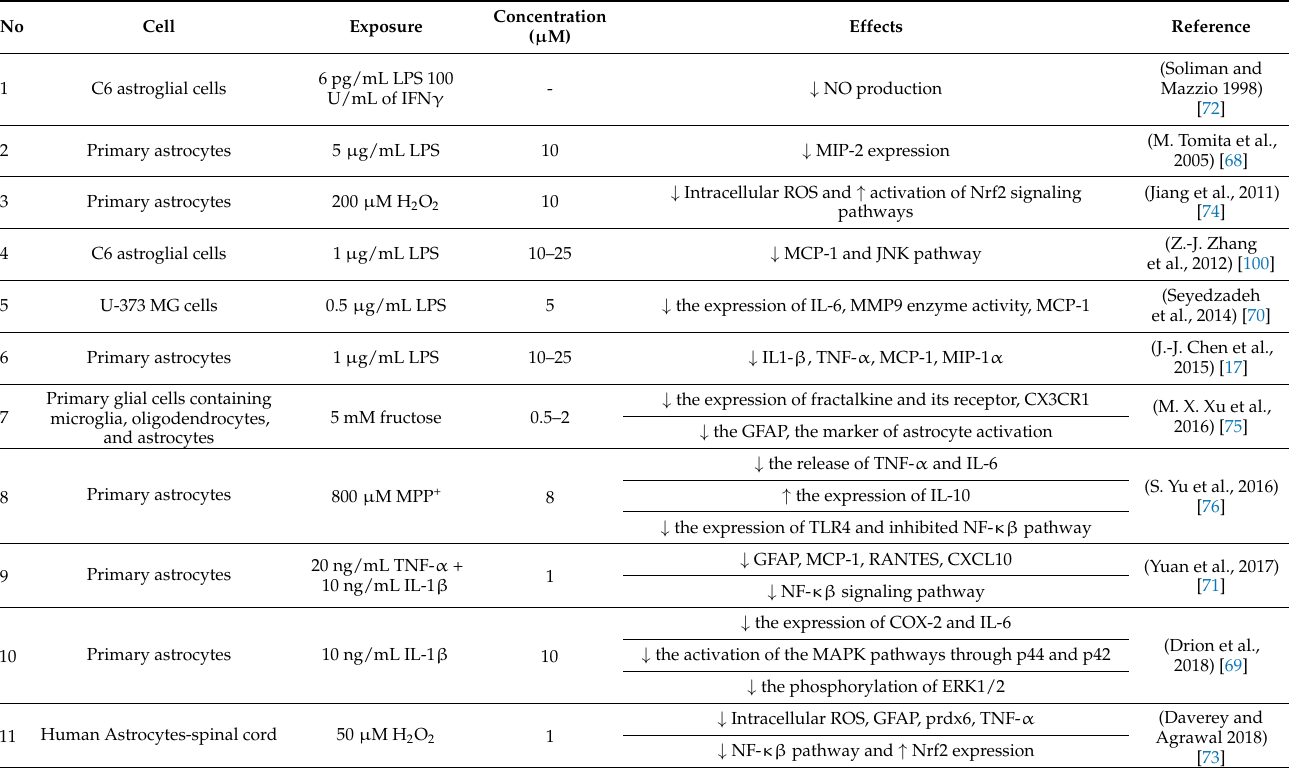
Table 2. Overview of the effect of curcumin on the activated astrocytes assayed in cultured